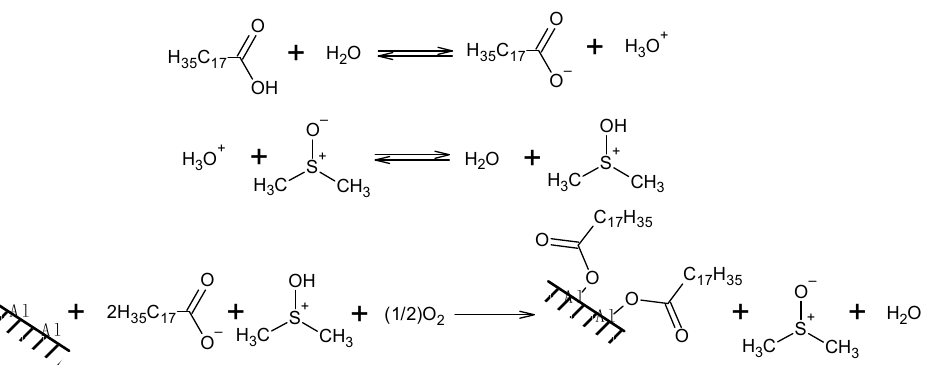
Figure 1. X-ray photoelectron spectra (XPS) of the coating: overview spectrum ( A ), aluminum ( B ), oxygen ( C ), carbon ( D ).